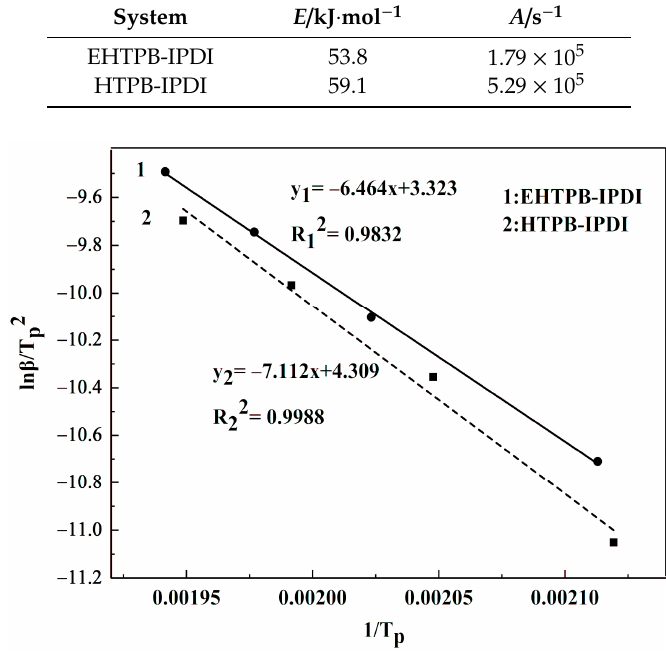
Figure 7. Determination of activation energy, E , of the EHTPB-IPDI and HTPB-IPDI systems, using the Kissinger method.